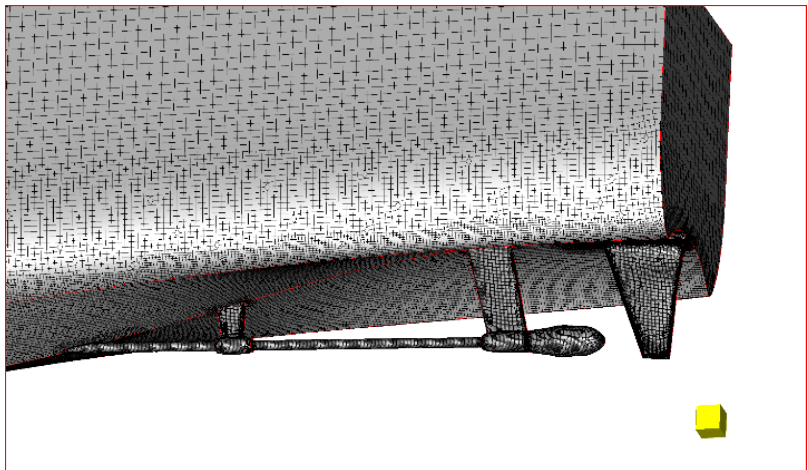
Figure 11. Numerical mesh around the stern tunnel area for the local optimization of the Stavanger demonstrator.